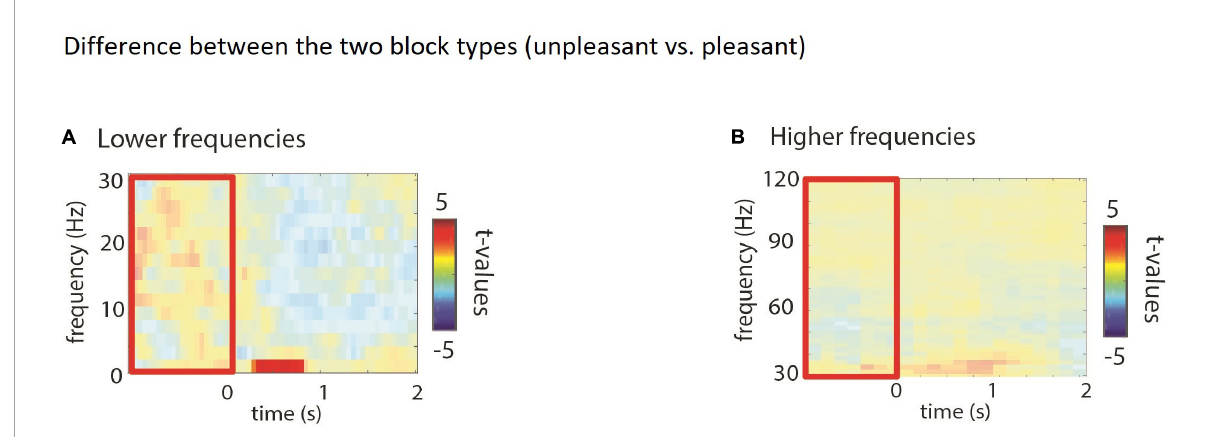
FIGURE2 (A,B) Comparing the inter trial interval (red box). Time-frequency representations of power when comparing blocks ( t -statistics), masked for significance. No significant difference in power neither in the low nor the high frequencies during the pre-stimulus interval was